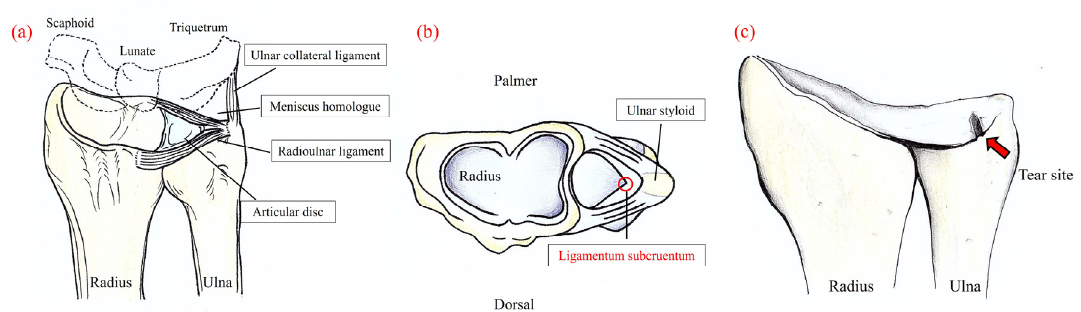
Figure 1. ( a ) Illustration of the main structures of the triangular fibrocartilage complex (TFCC). ( b ) Axial view. The ligamentum subcruentum is reported to be important for the stability of the wrist. ( c ) Tear site of the TFCC (Palmer type 1B).